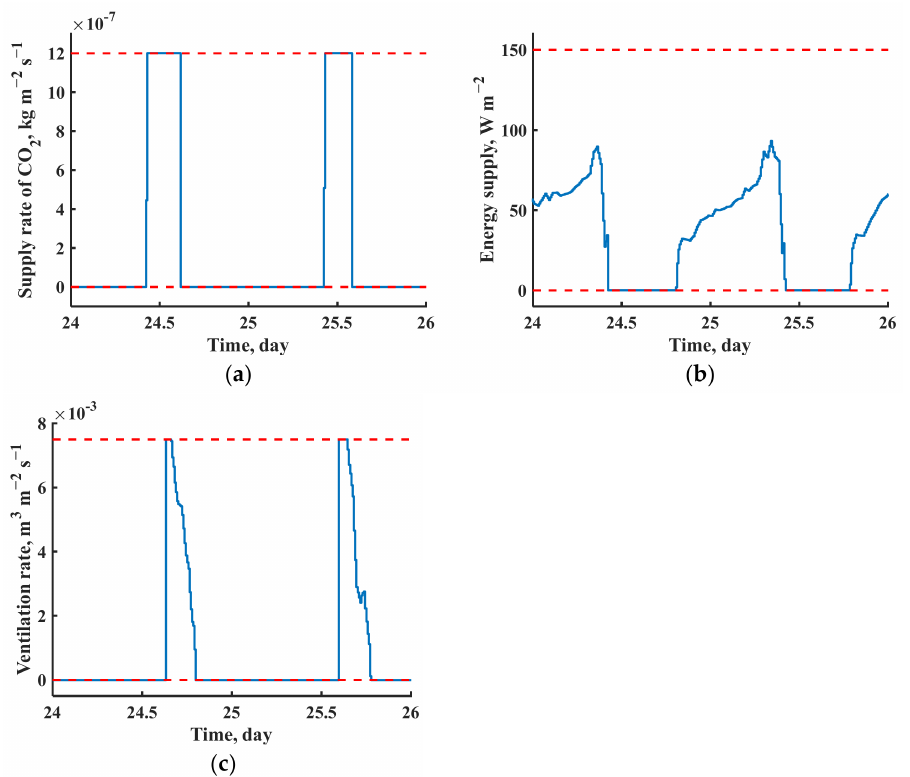
Figure 5. Control inputs during 2 days. ( a ) Supply rate of CO 2 , ( b ) Energy supply, ( c ) Ventilation